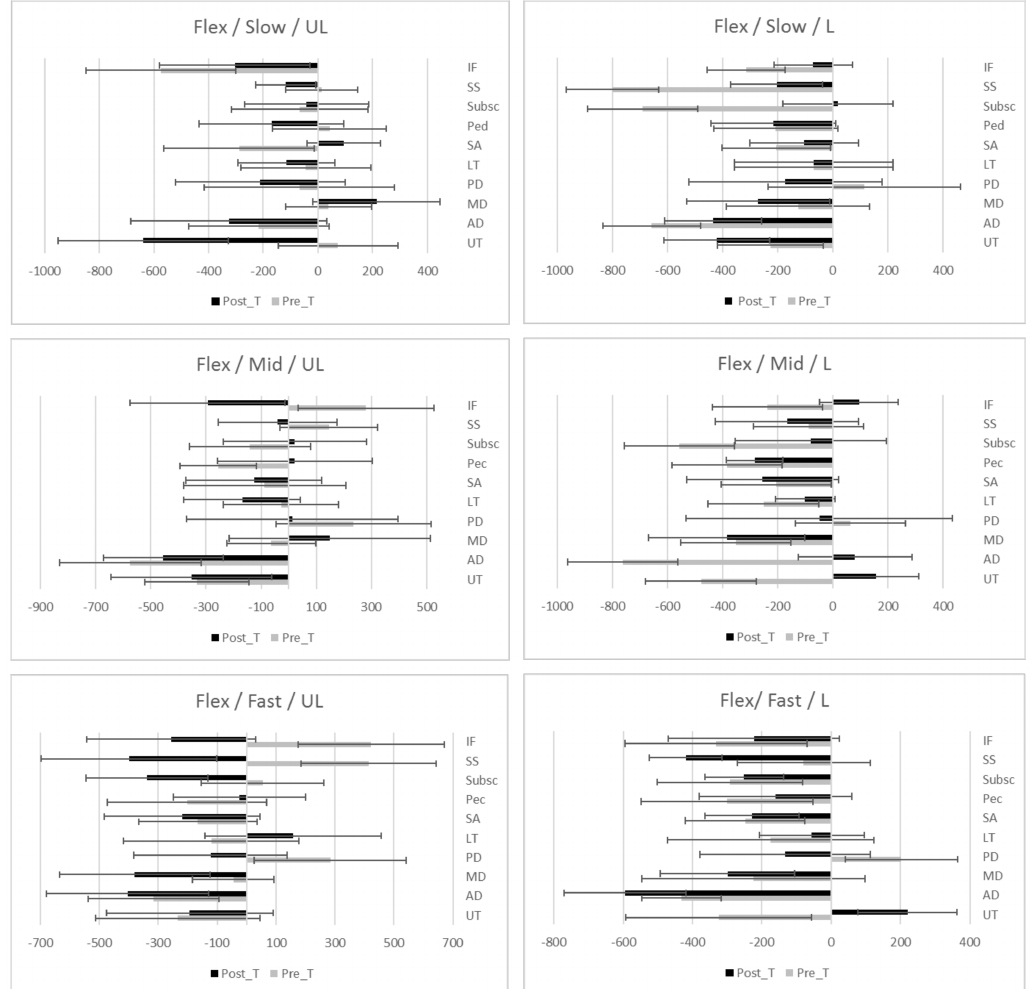
Figure 1. EMG onset time (ms) of activation (median ± IQR) during Flexion prior and after standardized physiotherapy treatment for SIS.Descriptive data: Median, IQR (Inter Quartile Range) of onset time of activation during flexion movement at different load and speed. UL (Unloaded), L (Loaded), Slow (slow speed), Mid (medium speed) Fast (fast speed). Muscles; UT (Upper Trapezius), AD (Anterior Deltoid), MD (Mid Deltoid), PD (Posterior Deltoid), LT (Lower Trapezius), SA (Serratus Anterior), Pec (Pectoralis Major), Susbc (Subscapularis), SS (Supraspinatus), IF (infraspinatus).